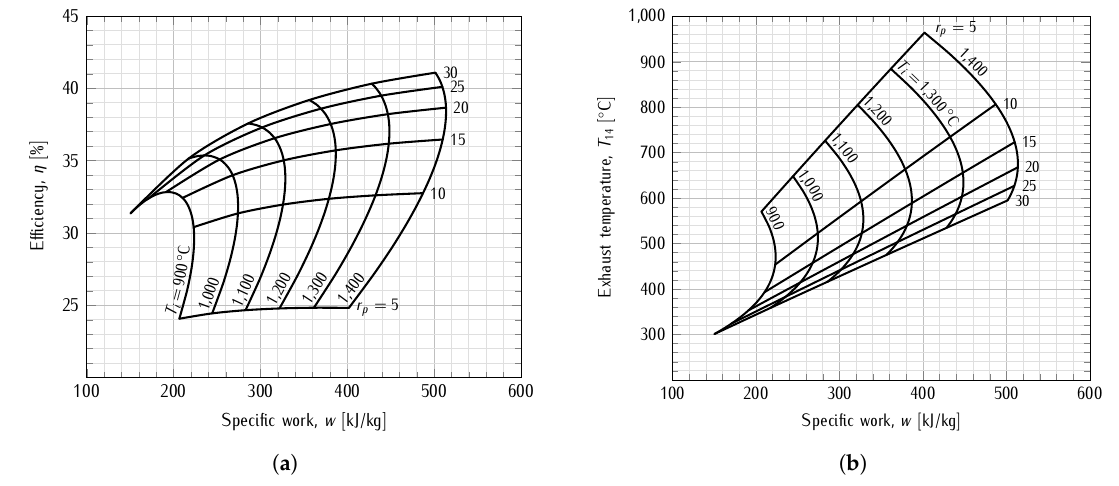
Figure 6. Validation of the gas turbine model; ( a ) η , w -Diagram; ( b ) T , w